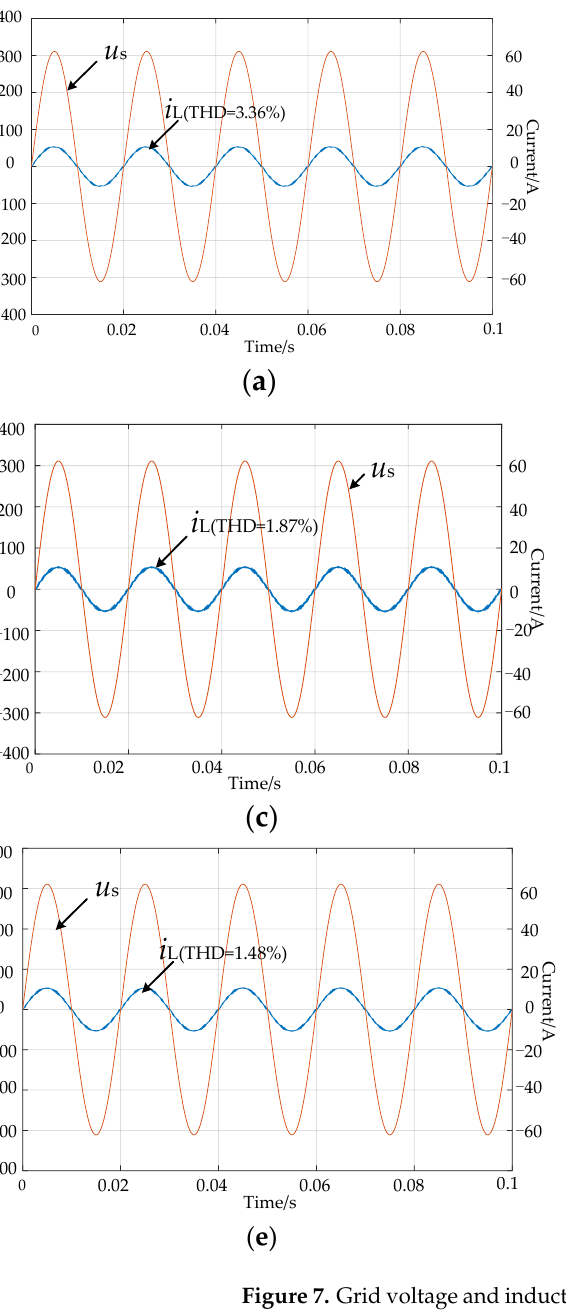
Figure 7. Grid voltage and inductive current under different modulation methods during steady - state operation. ( a ) SPWM. ( b ) SVPWM - 1. ( c ) SVPWM - 2. ( d ) SVPWM - 3. ( e ) SVPWM - 4(hybrid).